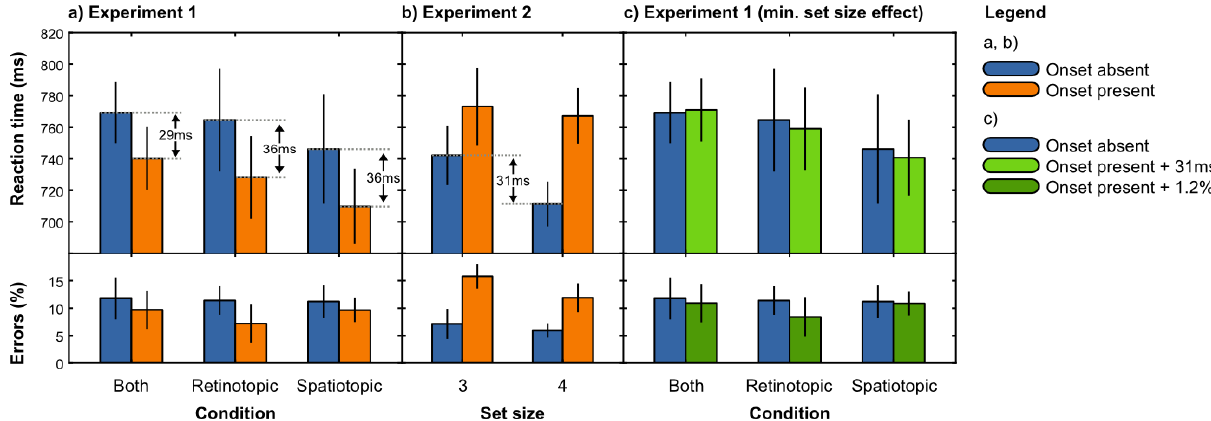
Figure 2. a) Results of Experiment 1. Participants were faster to respond if an intra-saccadic abrupt onset was presented. This 'paradoxical facilitation' was found in all three conditions (retinotopic, spatiotopic, and both). b) Results of Experiment 2. Participants were slower to respond if an abrupt onset was presented during fixation, reflecting the typical pattern of attentional capture. Importantly, if no abrupt onset was presented, participants were faster in the set size 4 condition than in the set size